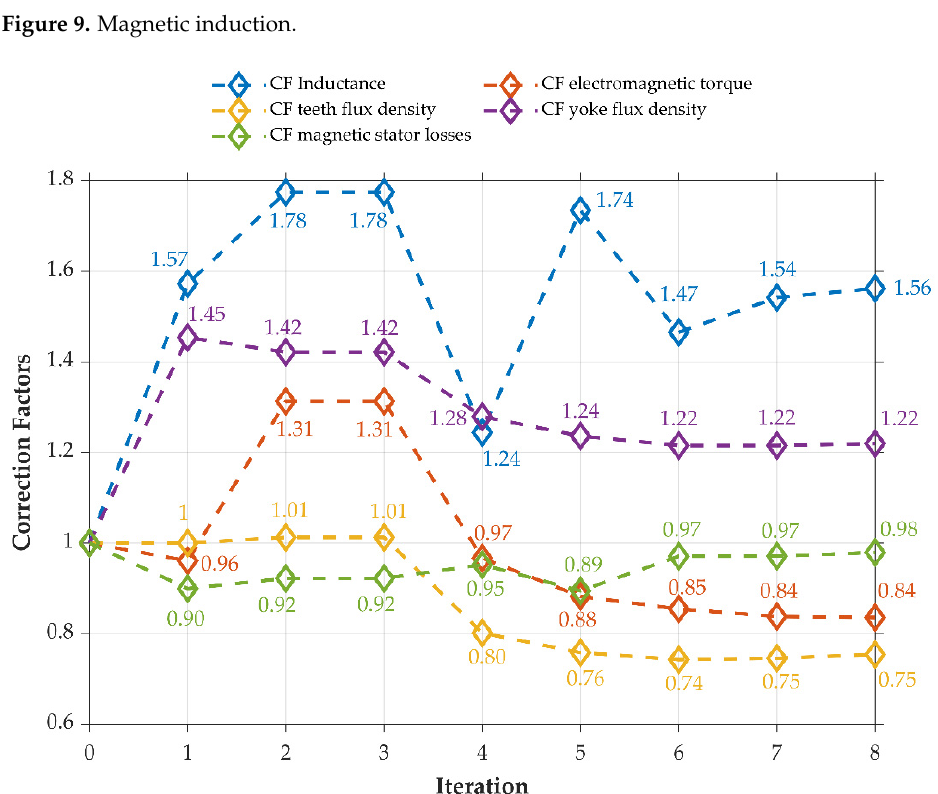
Figure 10. Evolution of correction factors.